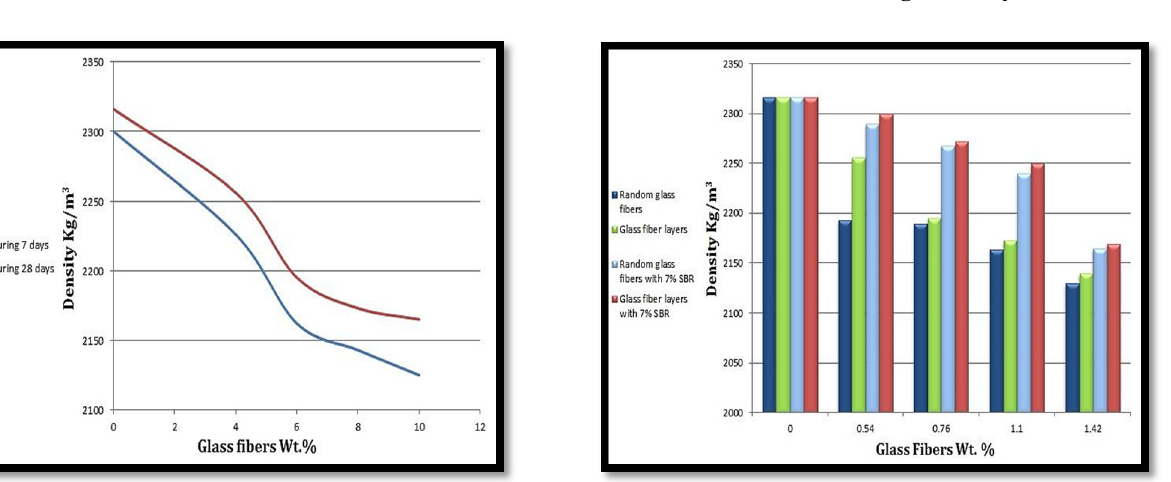
Fig. 6. Comparison between glass fibers reinforced mortar without SBR and glass fibers reinforced mortar with SBR after curing for 7 days.